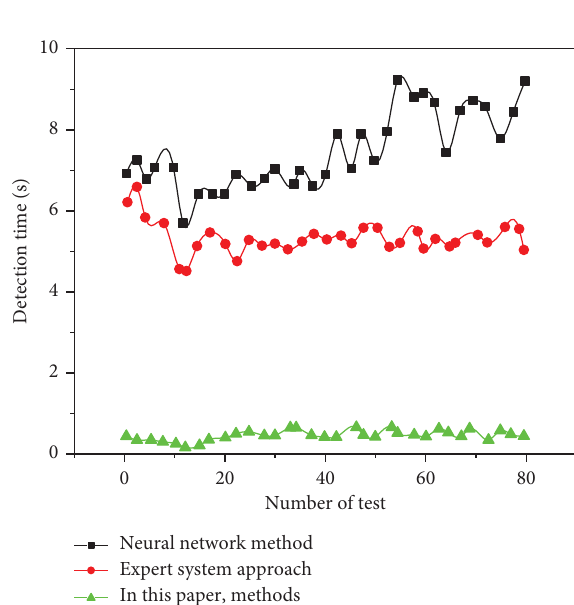
Figure 3: Comparison of detection time and diagnosis time of diferent methods. Figure 4: Comparison of the diagnosis time of diferent